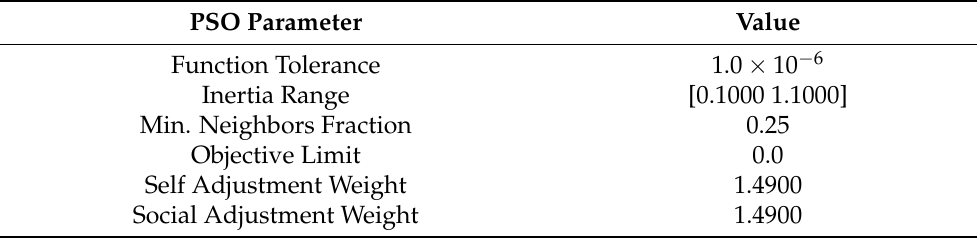
Table 1. Particle Swarm Optimization parameters.